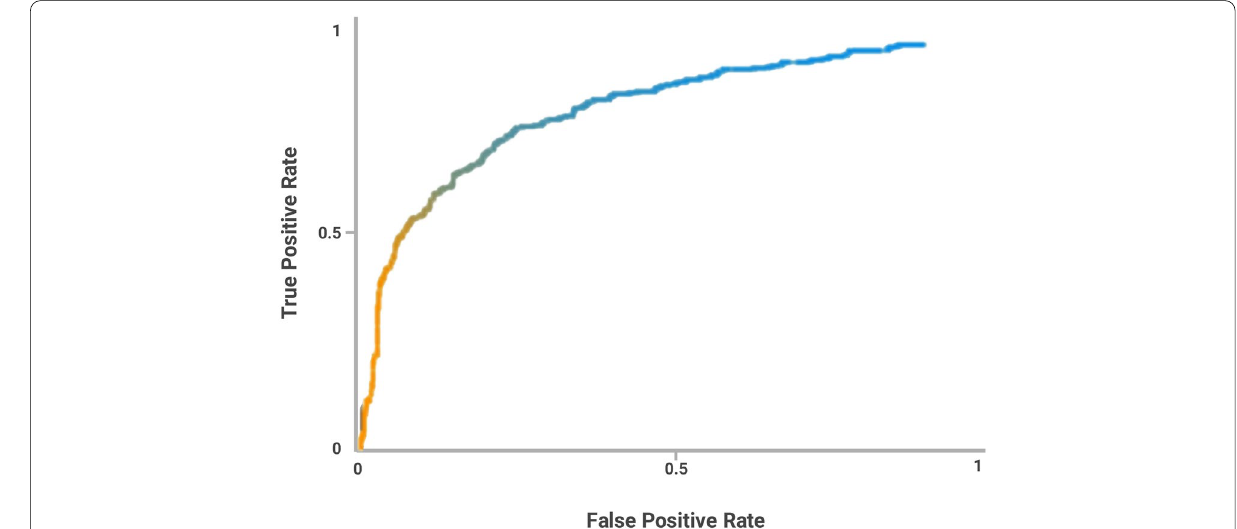
Fig. 5 ROC curve of Xalan 2.6